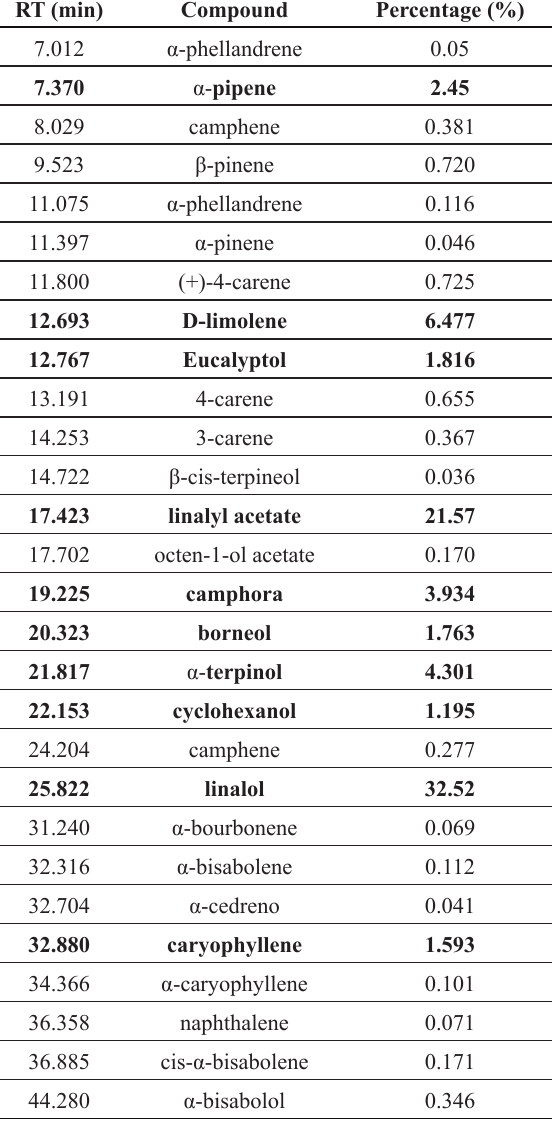
The percentage composition of the total oil from Lavandula